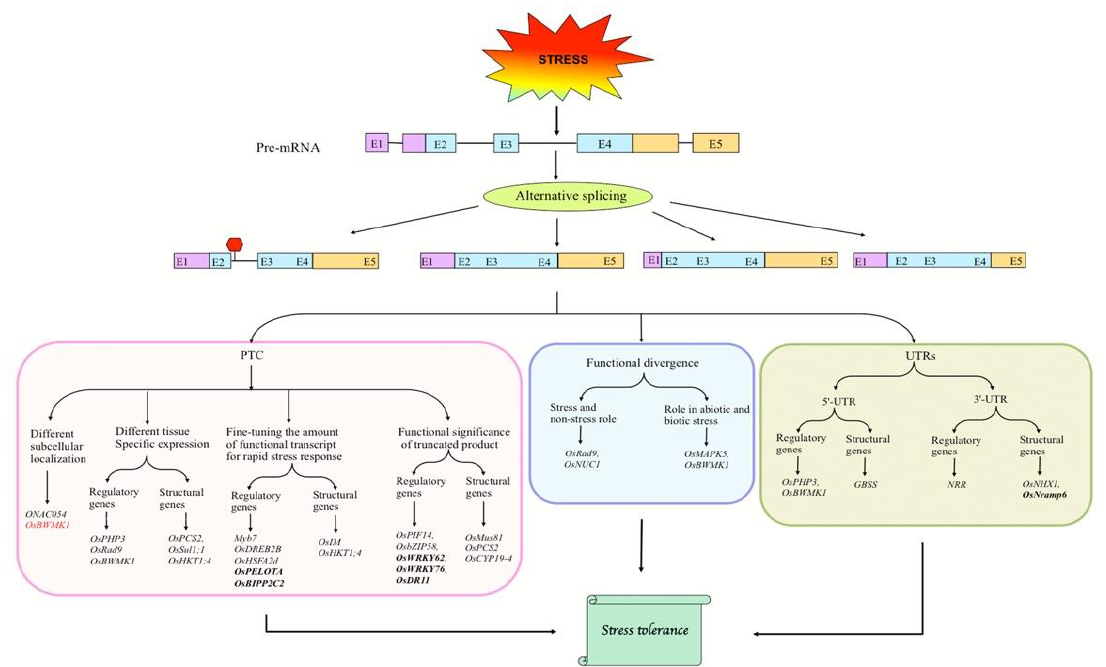
Figure 1. Various modes of AS-dependent regulation of splice isoforms in response to biotic and abiotic stresses. Under stress conditions, the pre-mRNA of stress-responsive genes may generate alternative transcripts with PTC that may regulate certain features of the splice isoforms, such as subcellular localization and spatial expression, which may fine-tune the level of functional protein isoforms or produce proteins with altered functions ( Left ). The alternative transcripts may be functionally distinct ( Middle ). Besides the coding region, stress-induced AS in UTRs of pre-mRNAs can also regulate splice isoforms ( Right ). Genes in bold represent biotic stress-responsive genes, and the remaining ones are abiotic stress-responsive. Gene shown in red functions in both biotic and abiotic stresses. Boxes and lines represent exons and introns, respectively. In transcripts, purple, sky blue, and orange colors represent 5′-UTR, coding region, and 3′-UTR, respectively. PTC, premature termination codon; Red hexagon represents PTC.